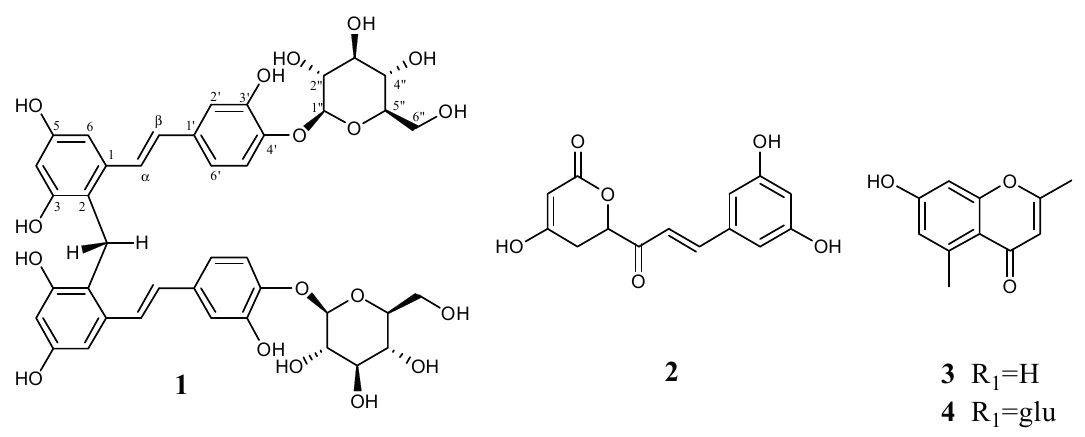
Figure 1. Chemical structures of compounds 1 – 18